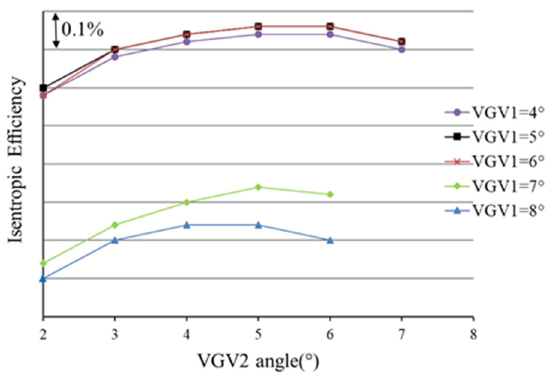
Figure 22. Maximum efficiency of the combination of turning angles in VGV joint adjustment.